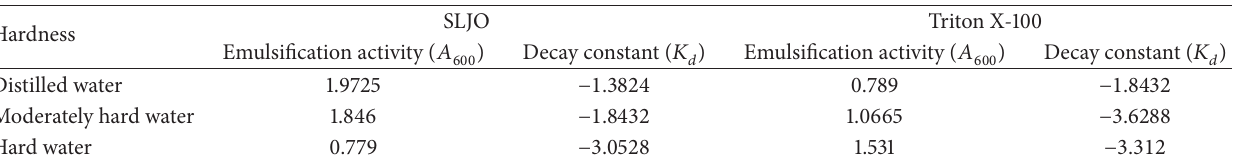
Figure 3: Antibacterial action of SLJO (a) against Staphylococcus aureus and (b) against Escherichia coli . The MIC 90 value has been marked with circle. Table 5: Effect of water hardness on emulsifying property and stability of SLJO and Triton X-100.